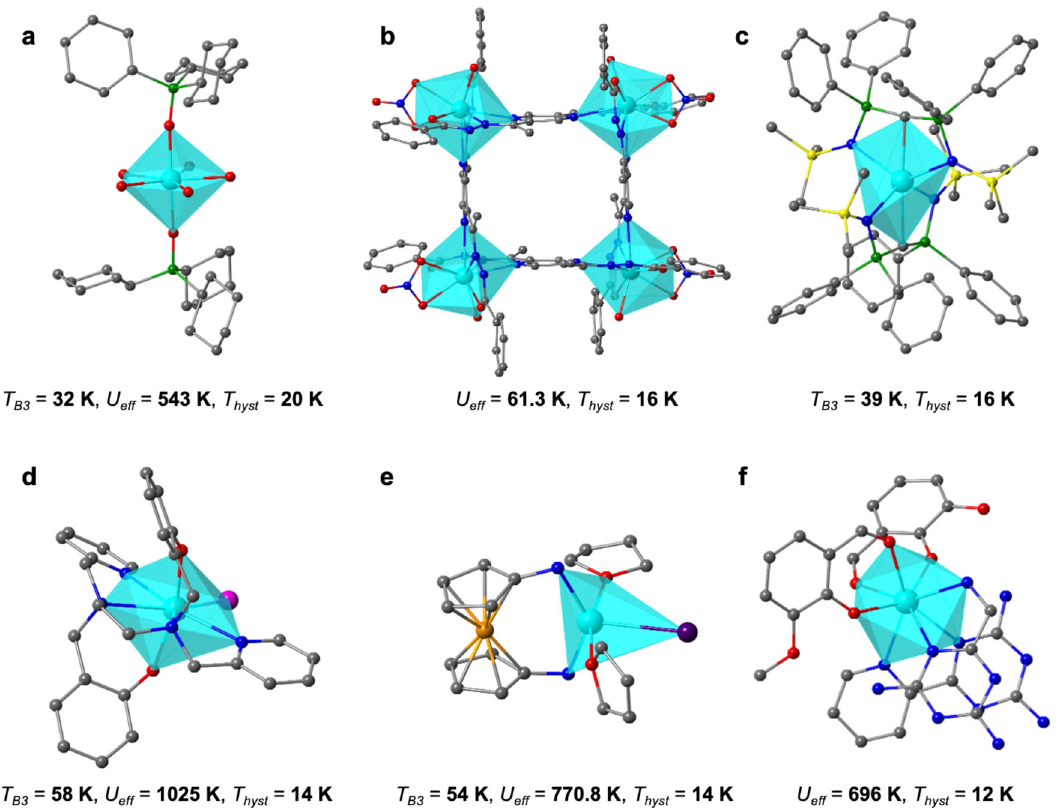
Fig. 7 | Promising systems for the development of new high- T hyst SIMs, all chemically distinct from each other and from the TbPc 2 and metallocene categories 47,74 – 78 . a [Dy(Cy 3 PO) 2 (H 2 O) 5 ] 3+ (Cy 3 PO = tricyclohexyl phosphine oxide) 47 ; b [Dy 4 (bzhdep-2H) 4 (H 2 O) 4 (NO 3 ) 4 ] (bzhdep = pyrazine-2,5-diyl- bis(ethan − 1-yl-1-ylidene)-di-(benzohydrazide)) 74 ; c [Dy(BIPM TMS ) 2 ] − (BIPM TMS ={C(PPh 2 NSiMe 3 ) 2 } 2 − ) 75 ; d [Dy(bbpen)Br] (H 2 bbpen=N,N ′